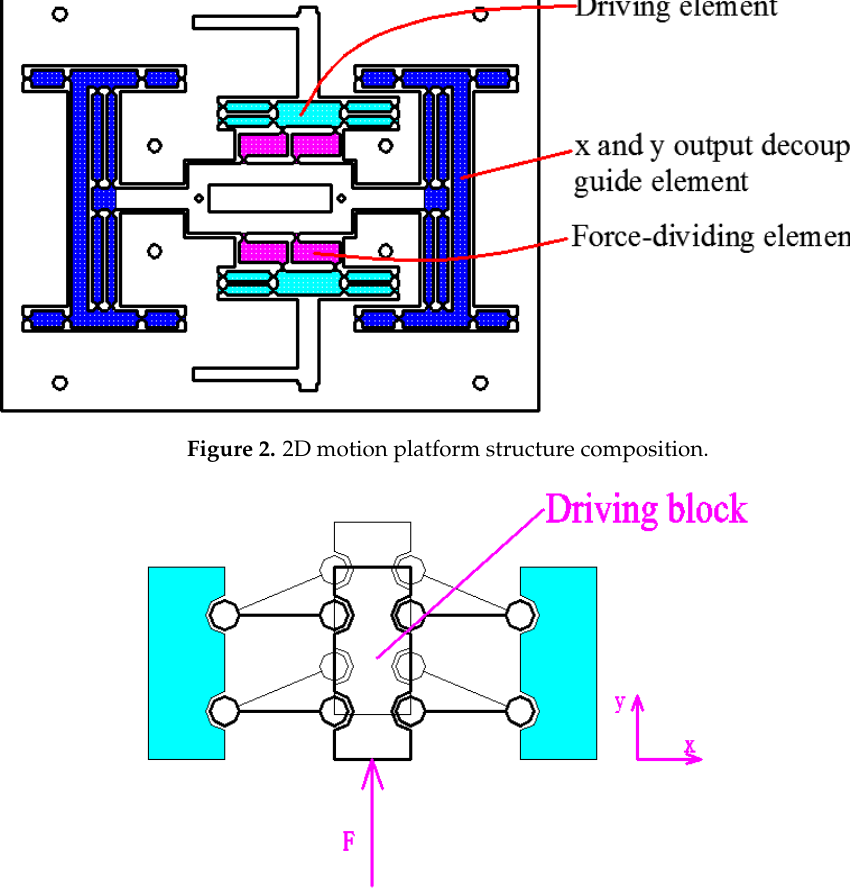
Figure 3. Principle of the driving element.